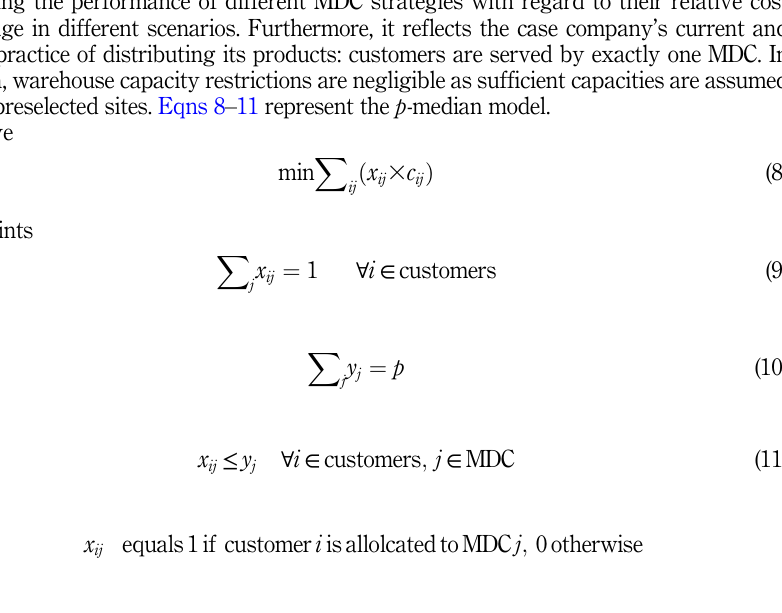
Table III. Because of the low influence of customer-MDC allocation on total inventory holding costs and the minor importance of inventory holding costs in overall distribution costs (about